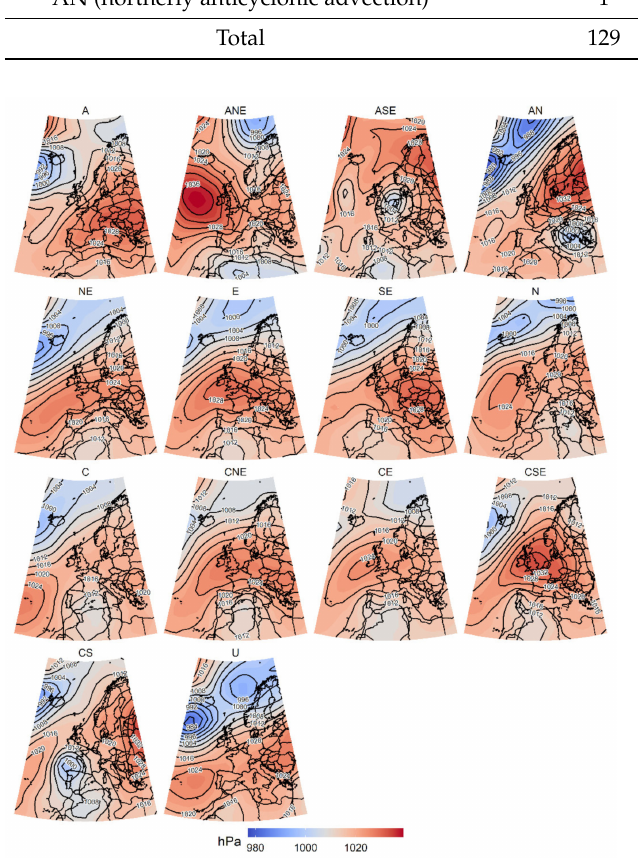
Figure 6. Synoptic patterns obtained from the J&C classification types representing days with equal to, or greater than, 100 mm of rainfall. The synoptic type is displayed on each map. The WeMOi was negative on 122 dates (94.57%) of the 129 events scrutinised in the study; it was positive on 4 dates (3.10%) (Figure 7) and no record exists on three days (2.33%) for the index (Appendix A). The mean value is − 1.5. The lowest one was −